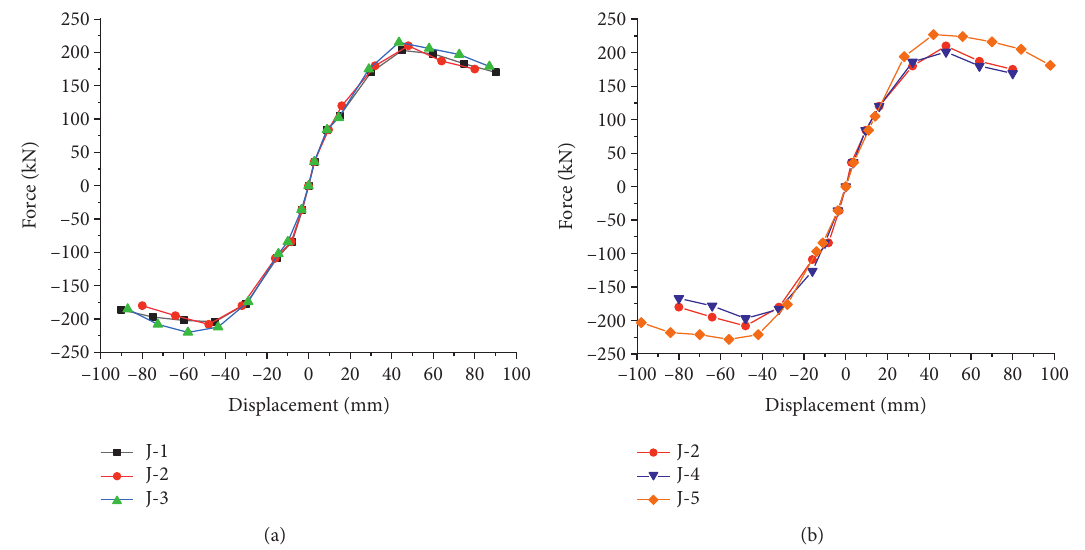
Figure 9: (a) Skeleton curve comparison (different coaxial compression ratio); (b) (different amount of